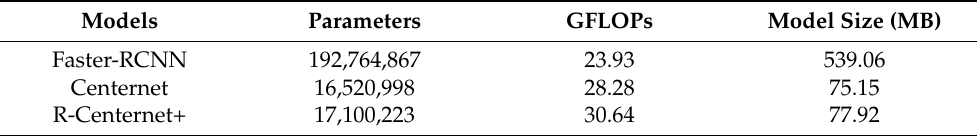
Table 11. Model comparisons with state-of-the-art models.